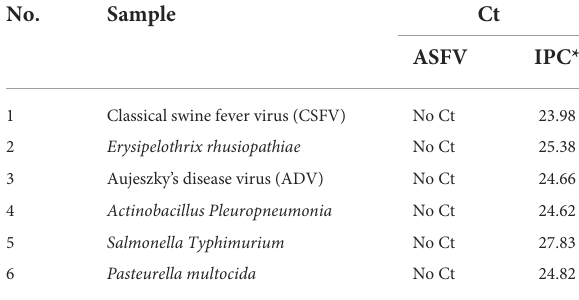
TABLE 6 Cross- reactivity of the ASFV assay